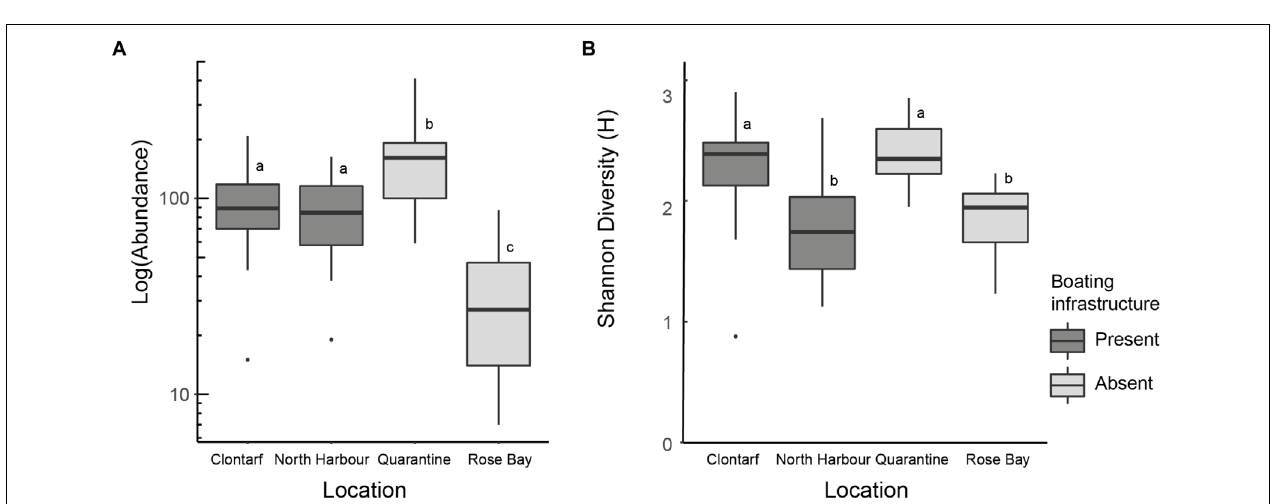
FIGURE 4 | The (A) abundance and (B) Shannons Diversity (H (cid:48) ) for each of the locations with boating infrastructure (Clontarf, North Harbour) and lacking boating infrastructure (Quarantine Bay, East Rose Bay). Locations sharing a letter do not differ in post hoc tests following (A) a negative binomial GLM and (B) a linear model contrasting all locations. Boxes indicate the upper and lower quartiles around the median, whiskers represent scores outside the middle 50%.